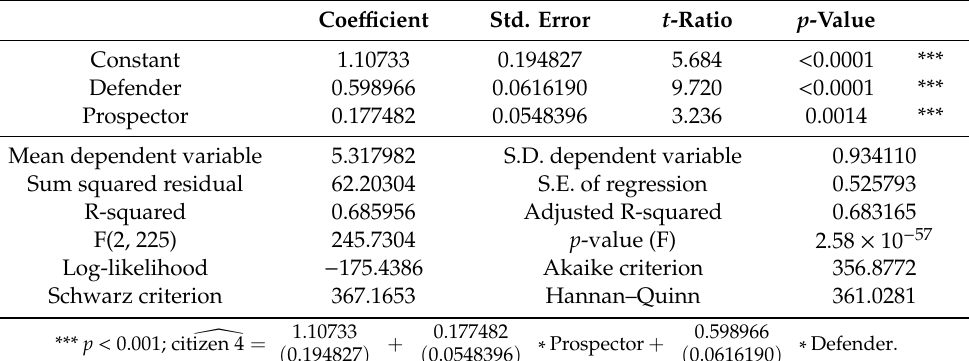
Table 4. Model 4: OLS, using observations 1–228. Dependent variable: Citizen